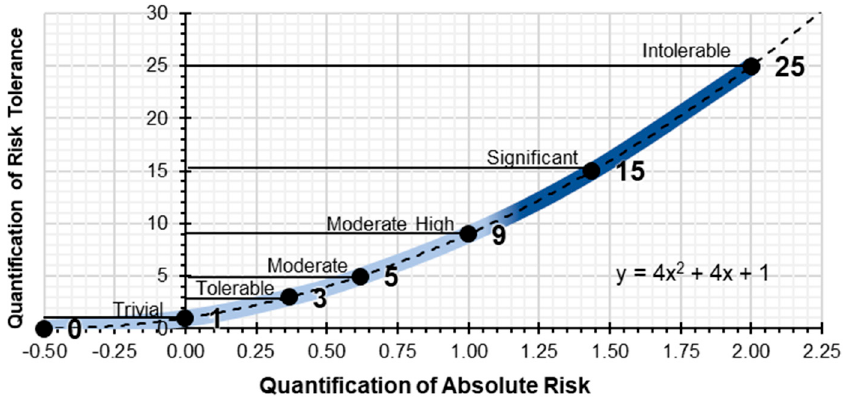
Figure 5. Graph showing the quantification of absolute risk.